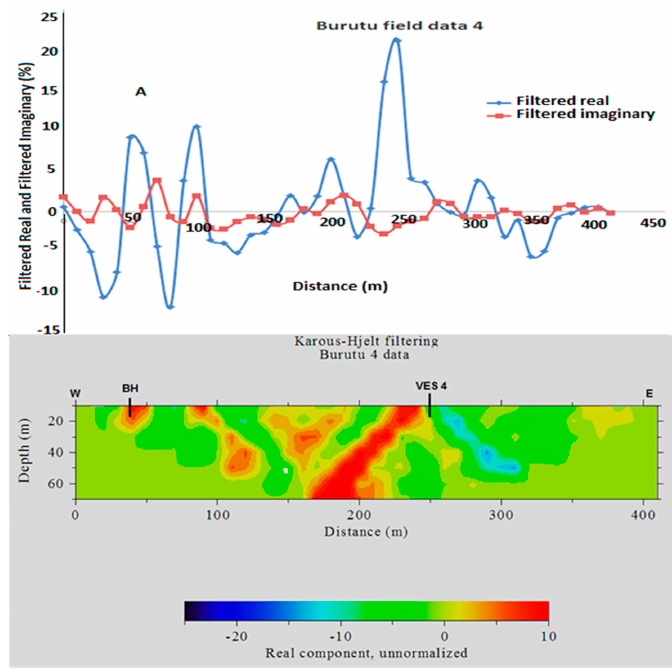
Figure 5. Plot of filtered Real and Imaginary components ( A ) and current density pseudo-section ( B ) for VLF Profile 4.